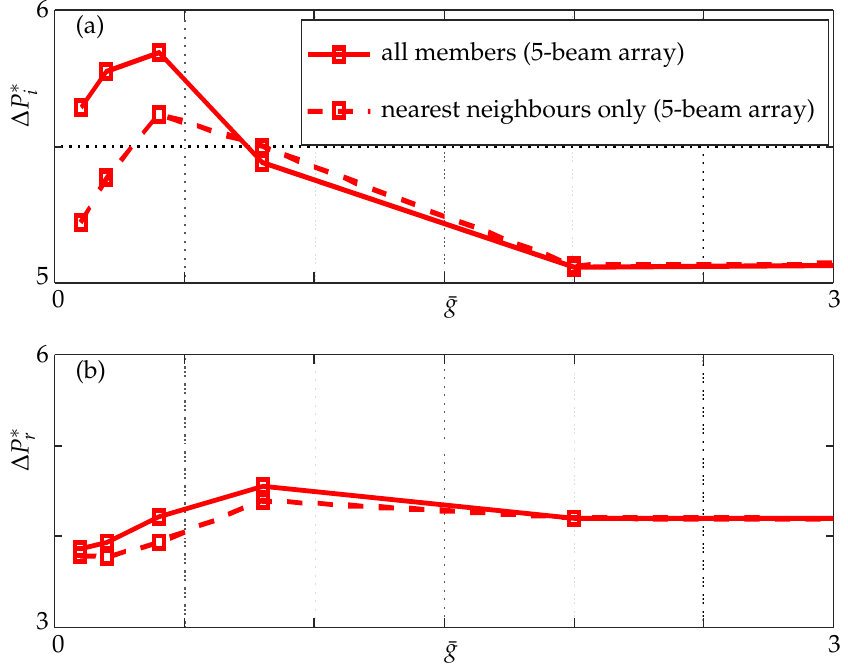
Figure 14. ( a ) Imaginary and ( b ) real parts of nondimensional pressure evaluated at the mid point of the active beam in a five-beam array (1–0–0–0–0 configuration) for different nondimensional gaps; nearest neighbours only (dashed lines) and all members incorporated (solid